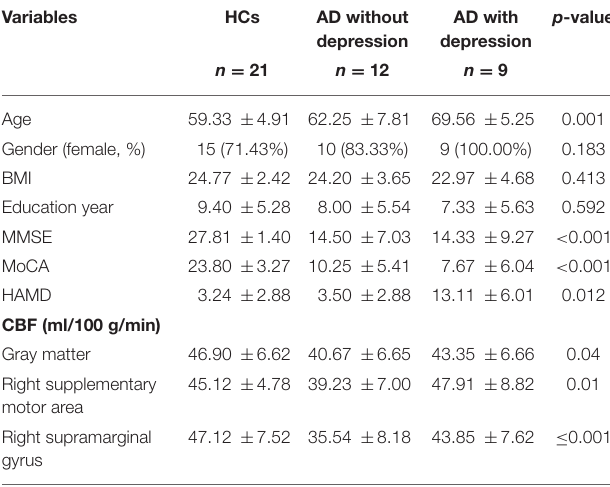
TABLE 1 | Demographics and clinical characteristics of the